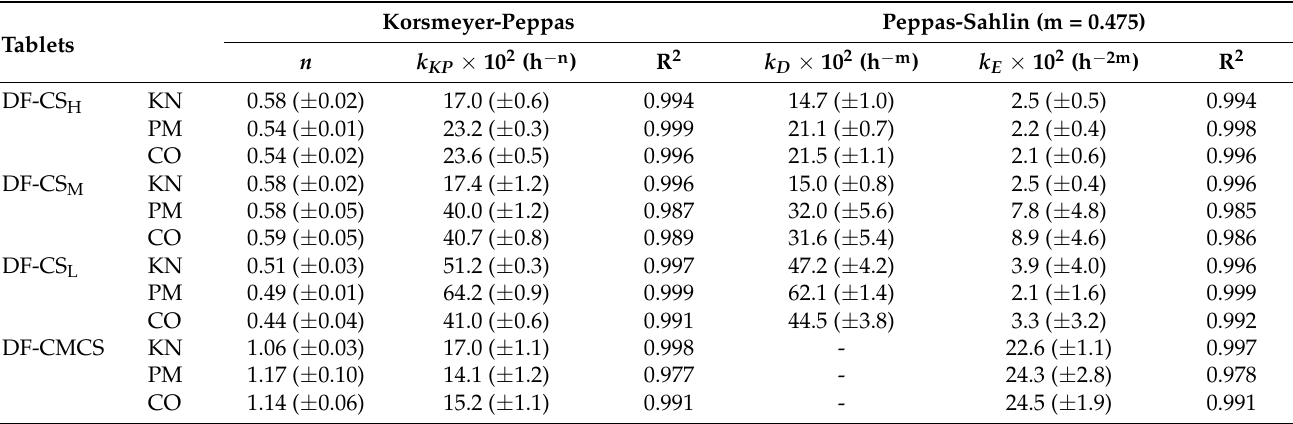
Table 3. Fitting results of the experimental diflunisal release data to Korsmeyer-Peppas and Peppas- Sahlin equations. Data represent the mean of at least 3